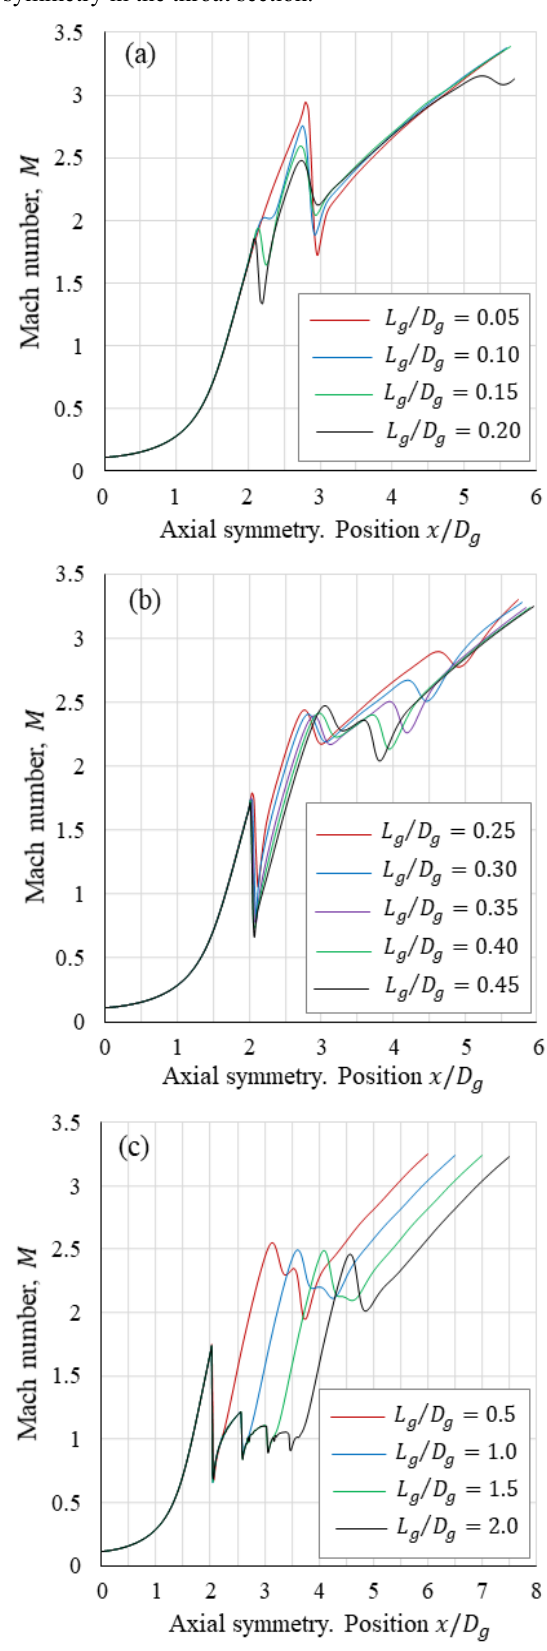
Figure 8. Mach number patterns. Throat length in the range (a) 0.05 ≤ L g /D g ≤ 2; (b) 0.25 ≤ L g /D g ≤ 0.45 (c) 0.5 ≤ L g /D g ≤ 2 . Source: